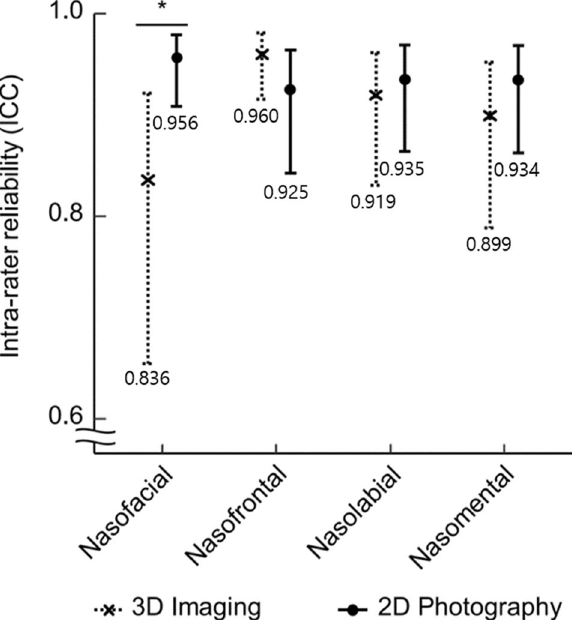
Figure 5. Comparison of intra-rater reliability of 3D imaging and 2D photograph (Crosses and Dots represented ICC, error bars represented 95% CI), showed significant difference in intra-rater reliability for the nasofacial angle (* p < 0.008). The value under error bars represented ICC